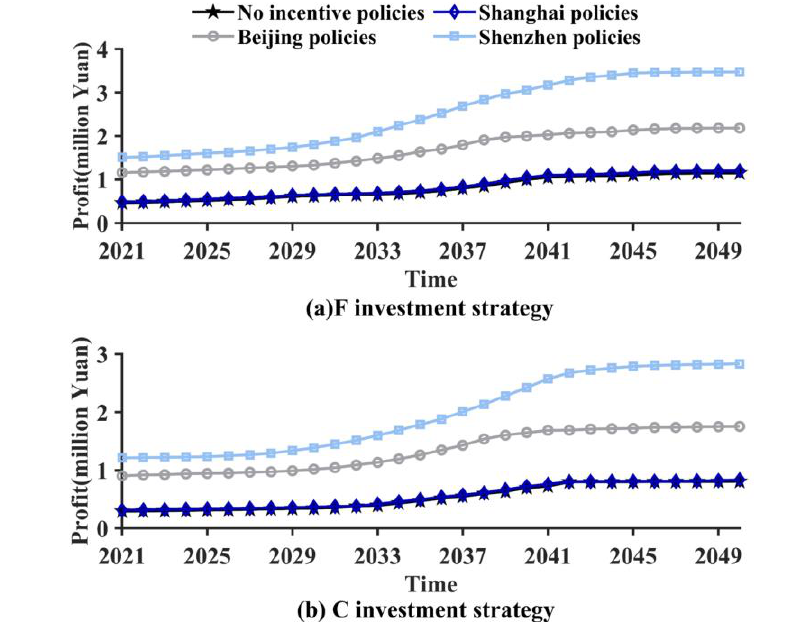
Figure 11. ECF-investment profit changes with different